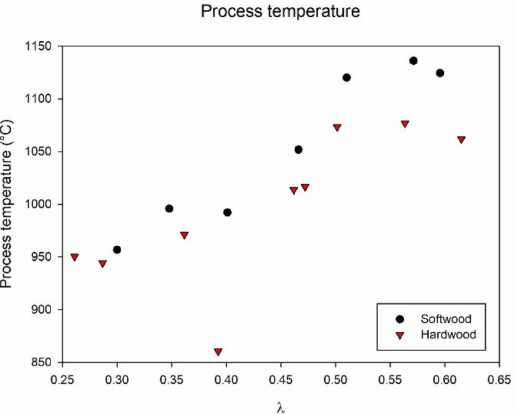
Figure 3. Process temperatures ( ◦ C) as a function of λ for softwood and hardwood bark